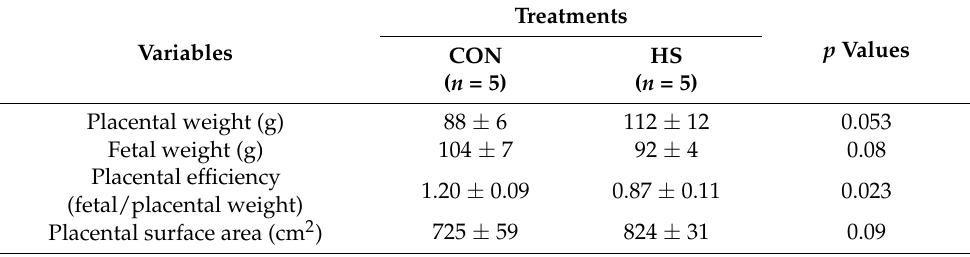
Table 1. Placental and fetal morphology from pregnant pigs exposed to thermoneutral control (CON, constant 20 ◦ C; n = 5) or cyclic heat stress (HS, 28 to 33 ◦ C; n = 5) conditions from d40 to d60 of